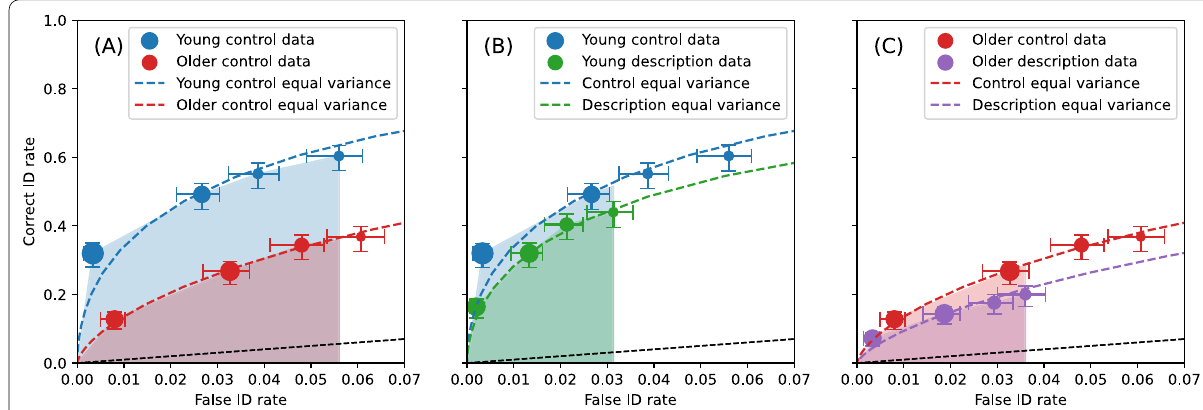
Fig. 1 ROC curves for the A young and older groups in the control condition, B control and experimental conditions for the young group, and C control and experimental conditions for the older group. The data were binned into 4 levels of confidence: high confidence (ratings of 6 and 7), medium–high confidence (rating of 5), medium–low confidence (rating of 4), low confidence (ratings of 3, 2 and 1). The size of each data point represents the relative frequency of the responses at each level of confidence. The region used for calculating pAUC for each condition is shown by the shaded regions. The dashed curves represent signal detection model fits (equal variance independent observation model). The error bars are 68% bootstrap confidence intervals, which are the bootstrap equivalent of 1 standard error. The black dashed line indicates chance performance ±